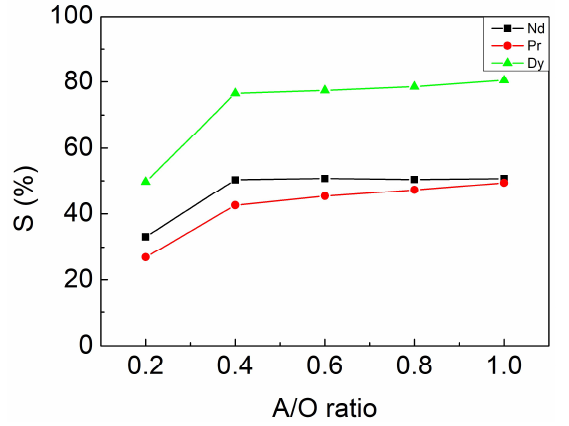
Figure 7. Stripping efficiencies at different A/O ratios. Fixed parameters: 0.1 M [HNO 3 ], contacting time of 10 min.